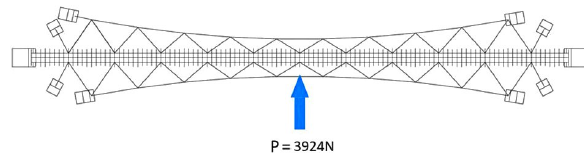
Figure 17. Lateral force P acting on central node of bridge deck